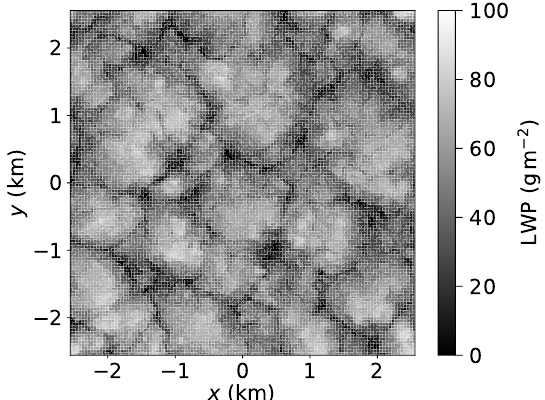
Figure 3. Liquid water path for a run without radiation, Case B3, at t = 1 h.